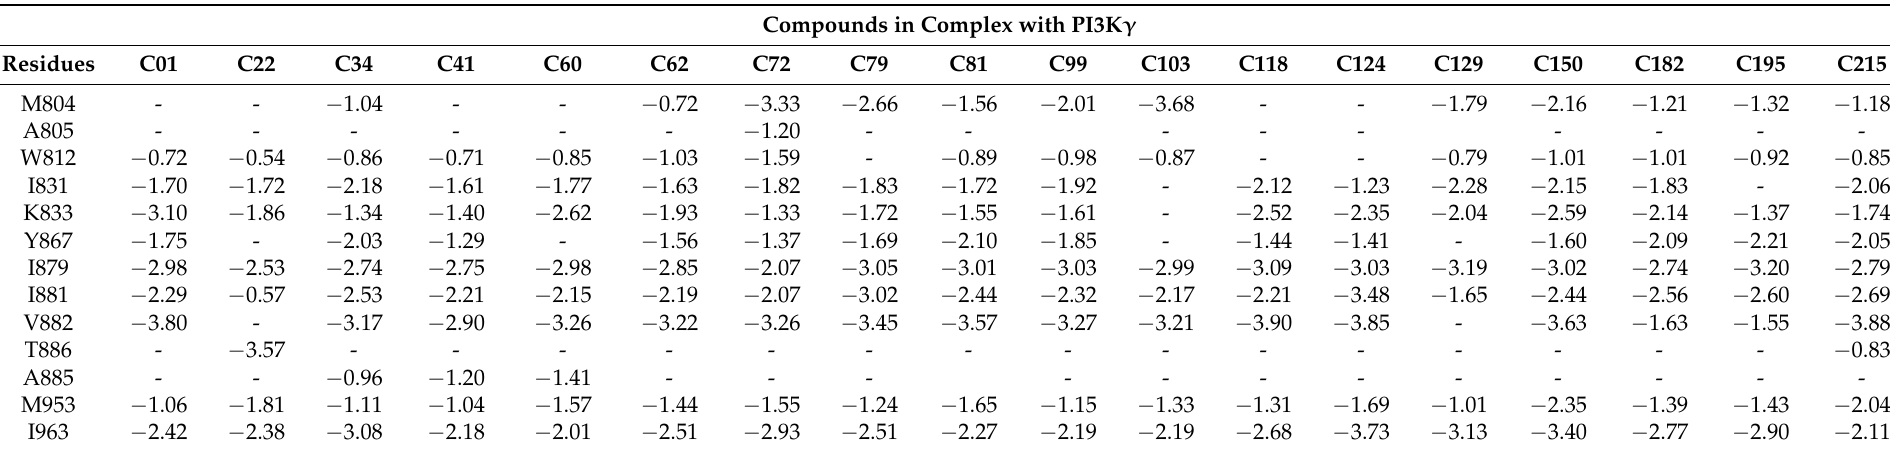
Table 3. Per-residue MM-PB/GBSA binding energy decomposition in